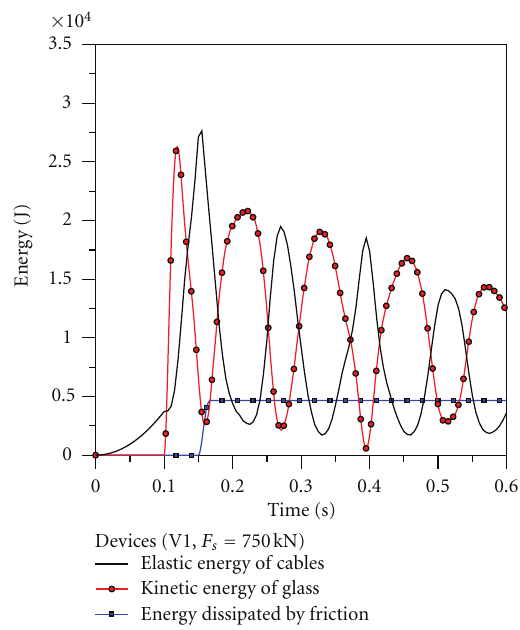
Figure 19: Energy terms of the fac¸ade-module (ABAQUS). Single vertical device (V1, F s = 750kN = 2 . 5H 0 ). M02 FE-model,